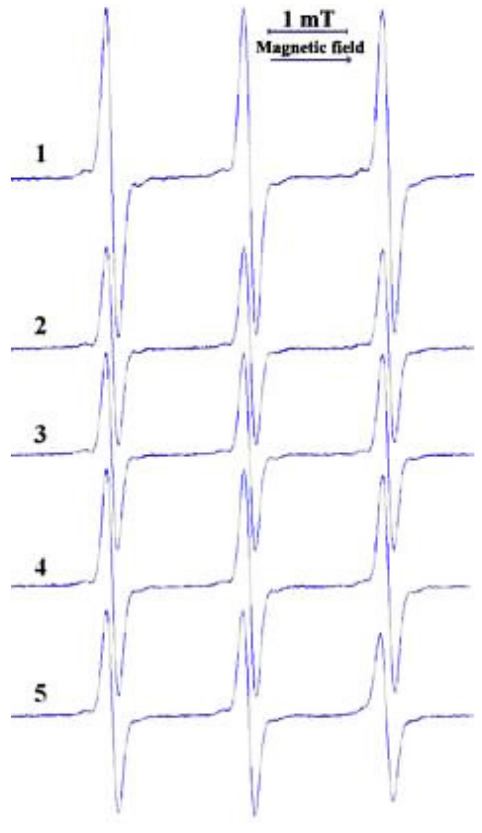
Fig. 5. EPR spectra of probe TEMPO in water (1) and aqueous solutions of BC at